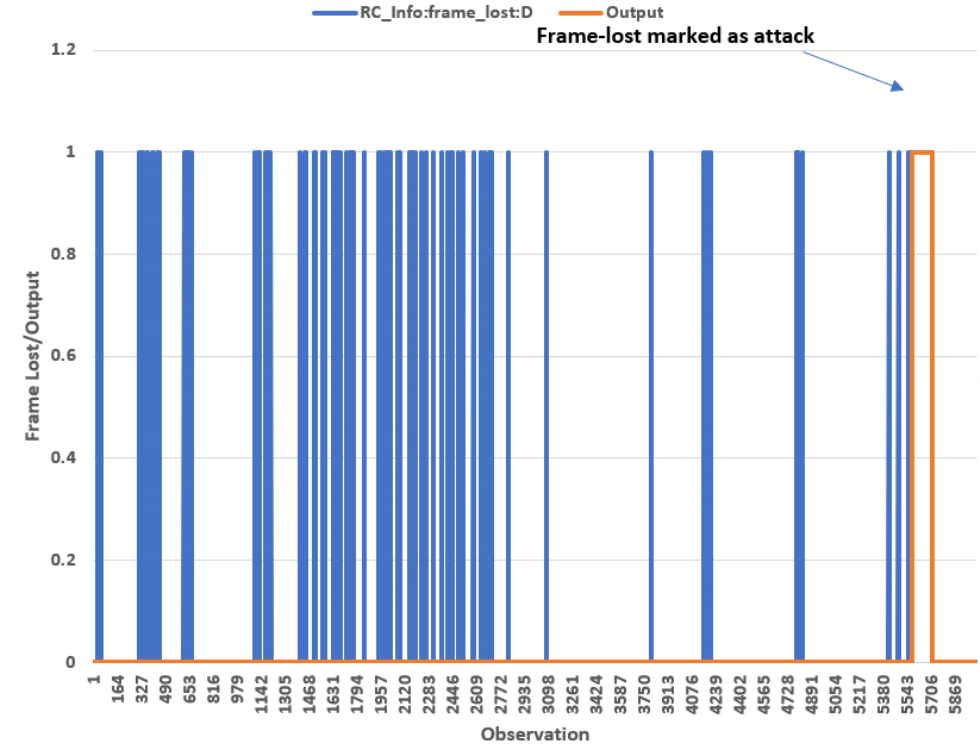
Figure 7. Continuous frame loss due to DoS attacks against the drone. As shown in Figure 8, the parameter rc_connect changes the state to zero, indicating a DoS attack. In Figure 7, blue lines indicate frame-loss recorded in the flight logs and orange lines indicate the label given to these instances.